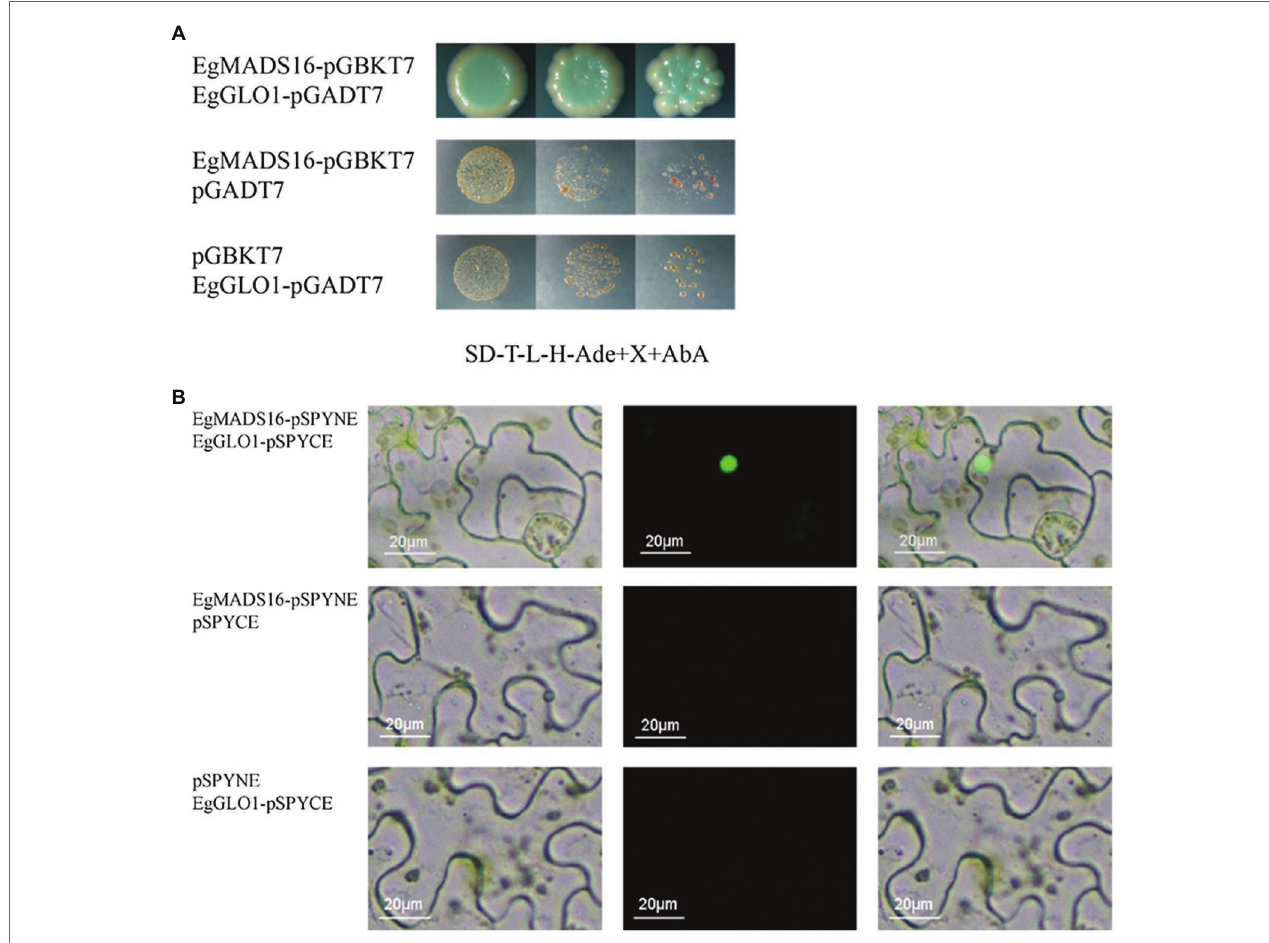
FIGURE 8 | EgMADS16 protein binds to EgGLO1 protein. (A) Yeast two-hybrid assay of EgMADS16 protein and EgGLO1 protein. (B) BiFC of EgMADS16 protein and EgGLO1 protein. Scale bar, 20 μ